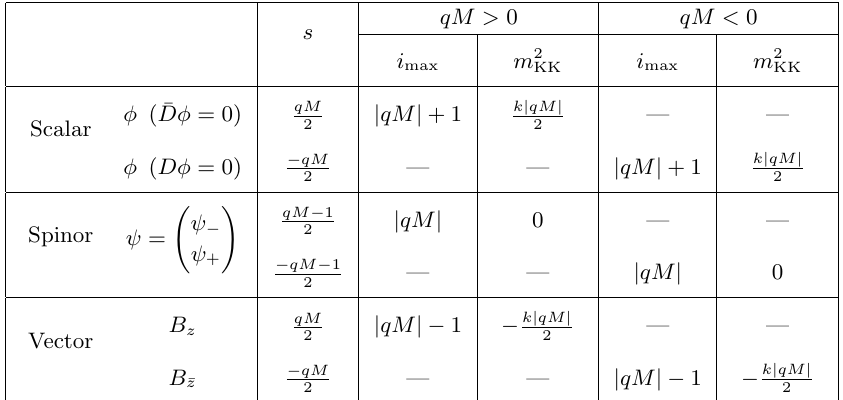
Table 1 . The power s , the degeneracy i max and the KK mass m 2 whose U(1) charge is q (see [3] for more